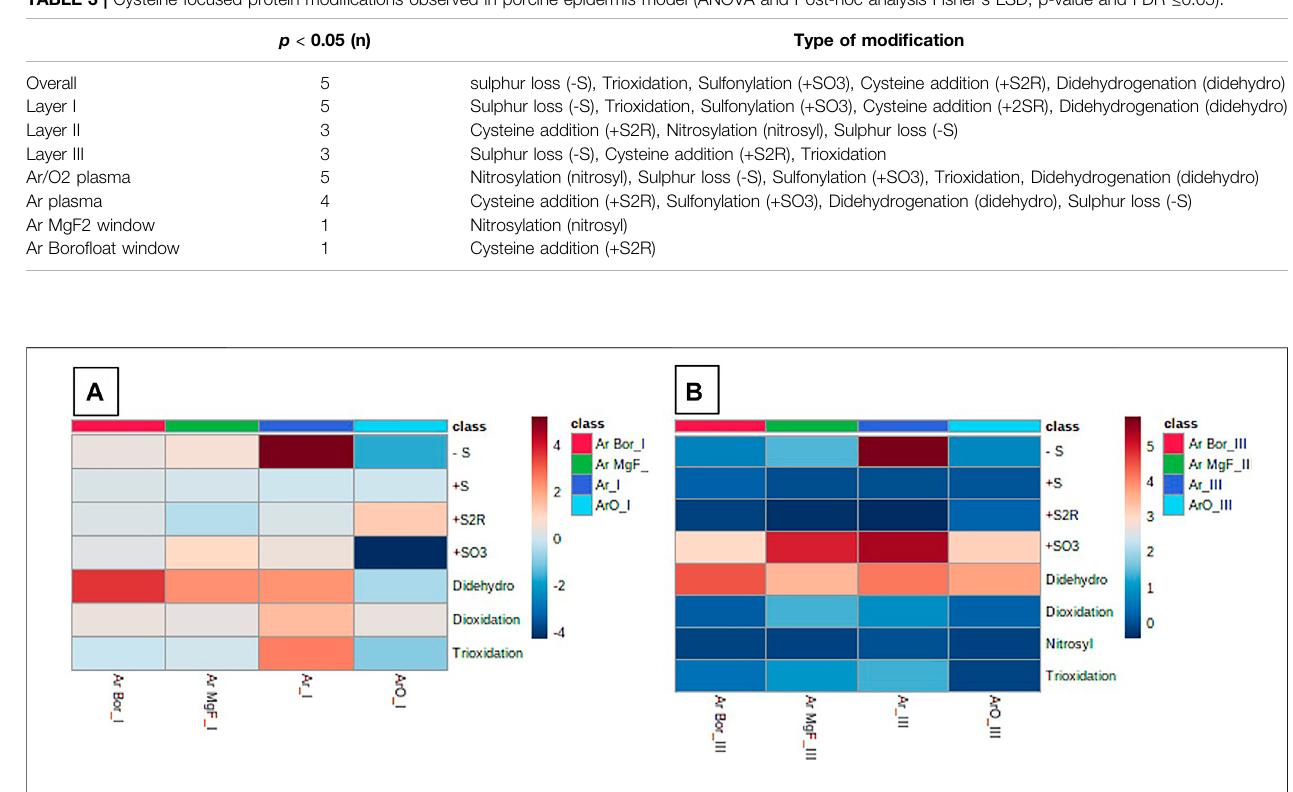
FIGURE 7 | Comparison of major modi fi cations observed in epidermis model (layer I/A and III/B). Conditions with free plasma or trough boro fl oat (Bor)/MgF 2 windowtreatmentsfor1 min cm − 2 arecompared.Layer III isclearly less affected thanlayerIand directplasmaismoreeffectivethan (UV)lightirradiation. VUVtreatment (MgF) is more effective than UVB (Bor). Further, see text and Table 3 . Relative changes in modi fi ed cysteine moieties shown via two-color gradient. Roman numbers indicate the layer with layer I the outer and laver III the inner layer investigated. Experiment performed in